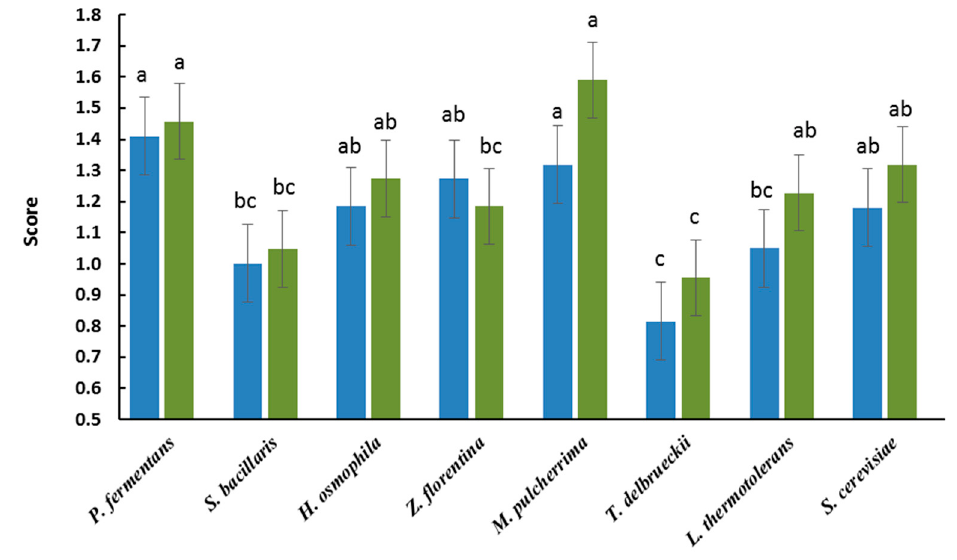
Figure 6. Sensory perception of astringency ( ■ ) and dryness ( ■ ) in wines 4 months after bottling (QDA: scale 1–4) Values displaying different letters (a, b, c, d) are significantly different according to the Duncan test (for astringency at p ≤ 0.01 and for dryness at p ≤ 0.001). M . pulcherrima , while the association T . delbrueckii / S . cerevisiae proved the most e ff ective in reducing this sensation in the